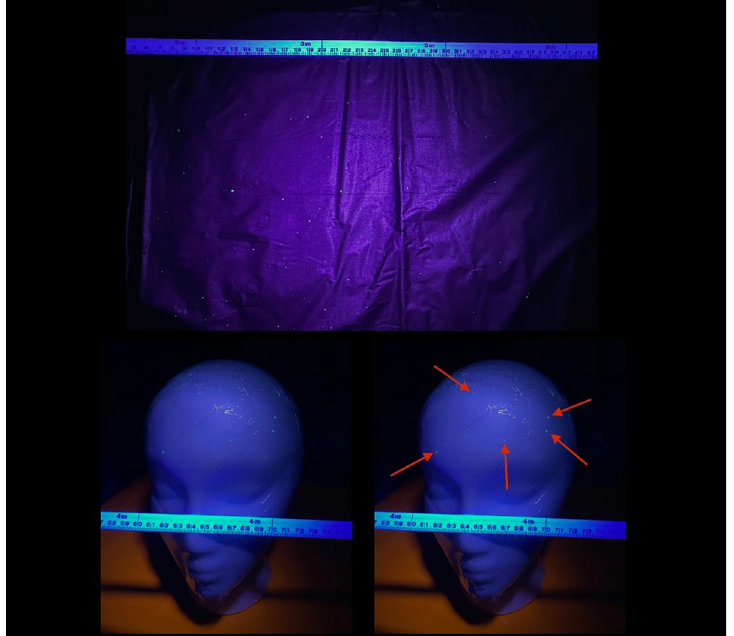
(B) Five fluorescent paint droplets were found on the forehead of one of the mannequins surrounding M1. (C) Arrows point to five fluorescent paint droplets on the head of the mannequin.